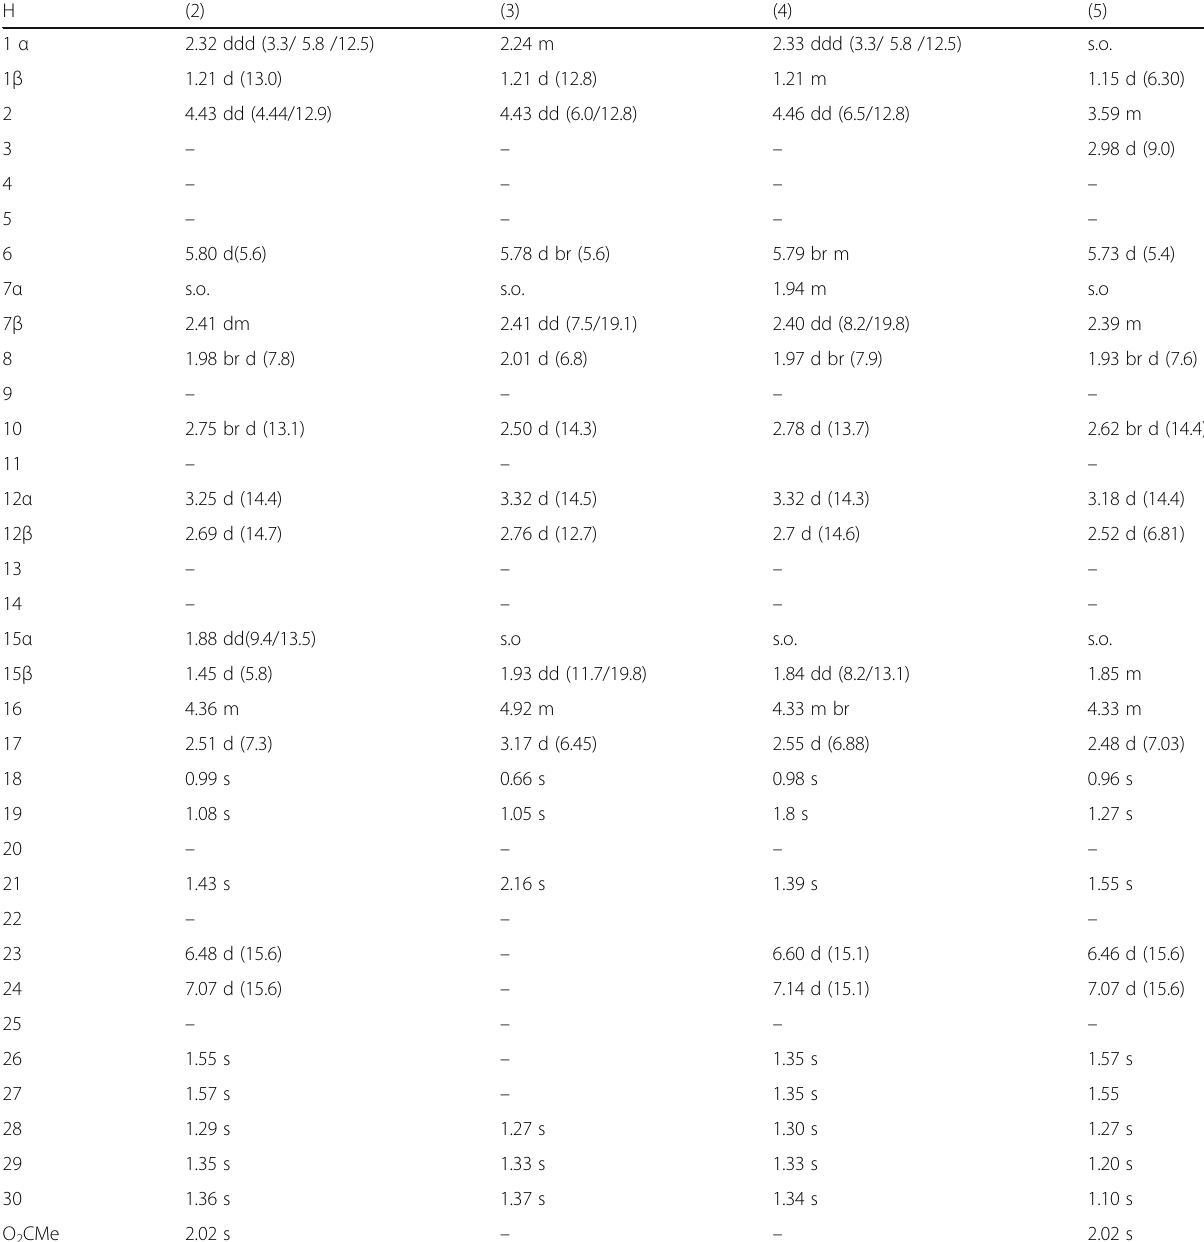
Table 1 1 H-NMR spectral data for compounds 2, 3, 4 and 5 in CDCl 3a (400